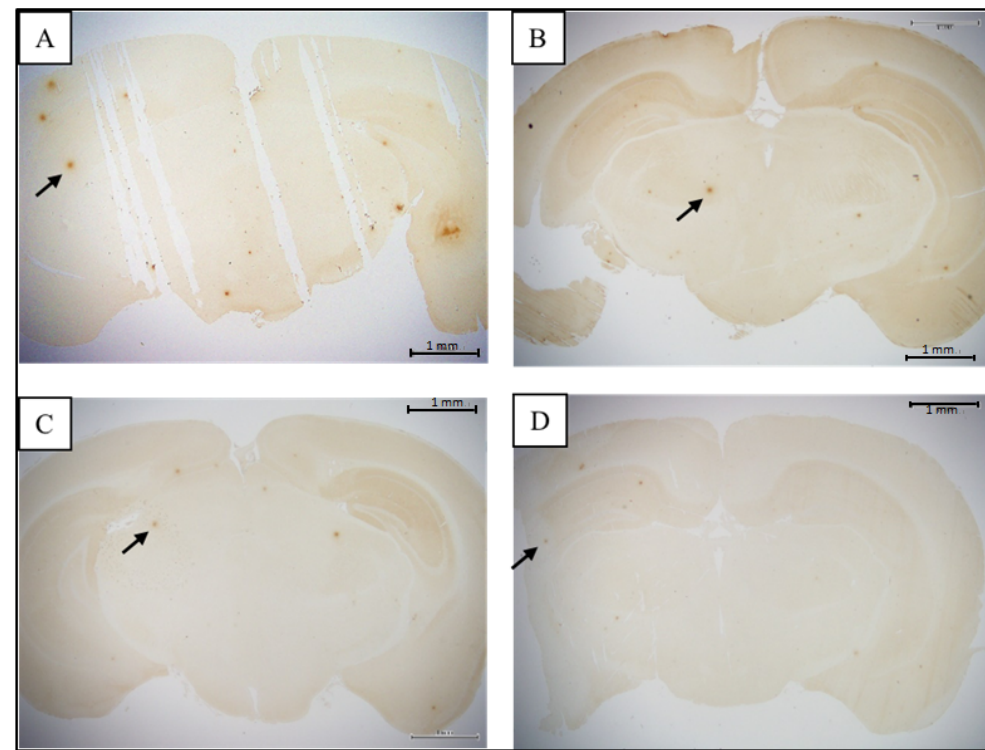
Figure 5. β -amyloid plaque in male mice (20× magnification). ( A ) = control (ddH 2 O), ( B ) = low dose (108 mg/kg BW/day), ( C ) = medium dose (215 mg/kg BW/day), ( D ) = high dose (431 mg/kg BW/day) (n = 5). Arrows indicate β -amyloid plaque.